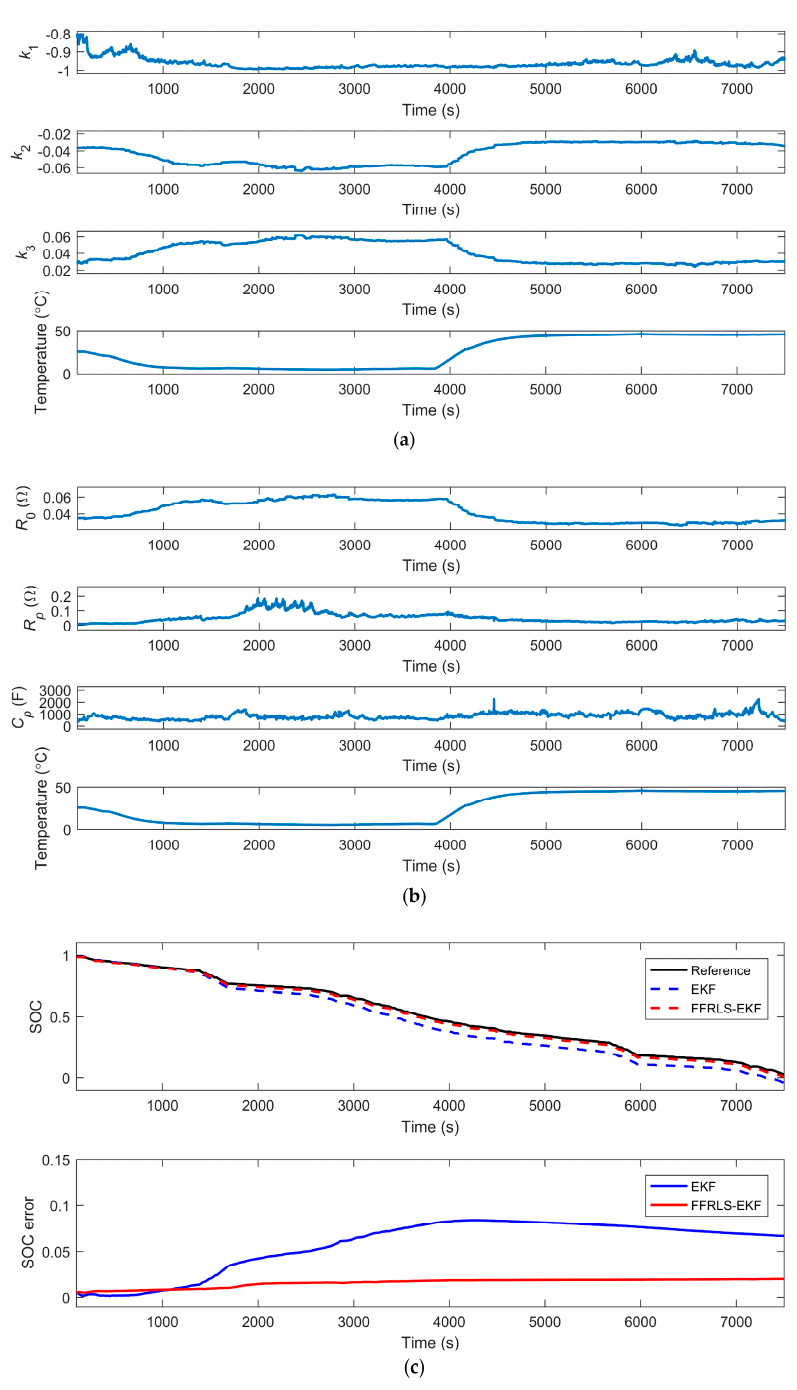
Figure 10. Calculation results of EKF and FFRLS-EKF with measurement noise: ( a ) Identification of k 1 , k 2 and k 3 ; ( b ) Identification of R 0 , R p and C p ; ( c ) SOC estimation results of EKF and FFRLS-EKF.